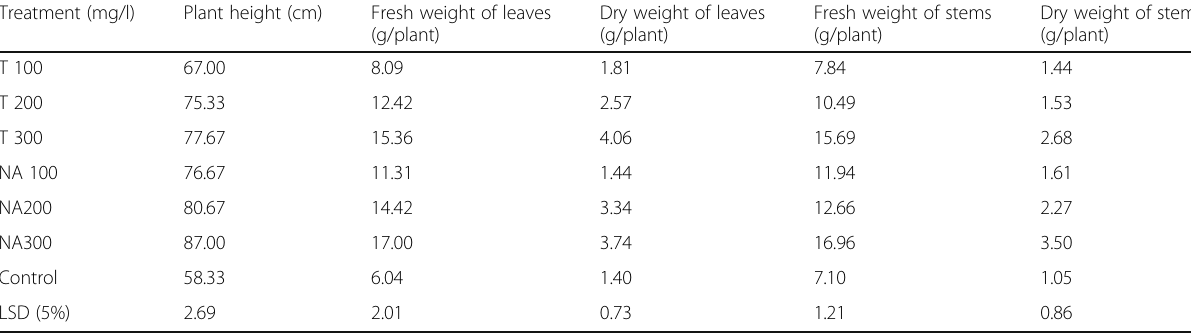
Table 2 Effect of tryptophan and nicotinamide on growth of guar plants Treatment (mg/l) Plant height (cm) Fresh weight of leaves